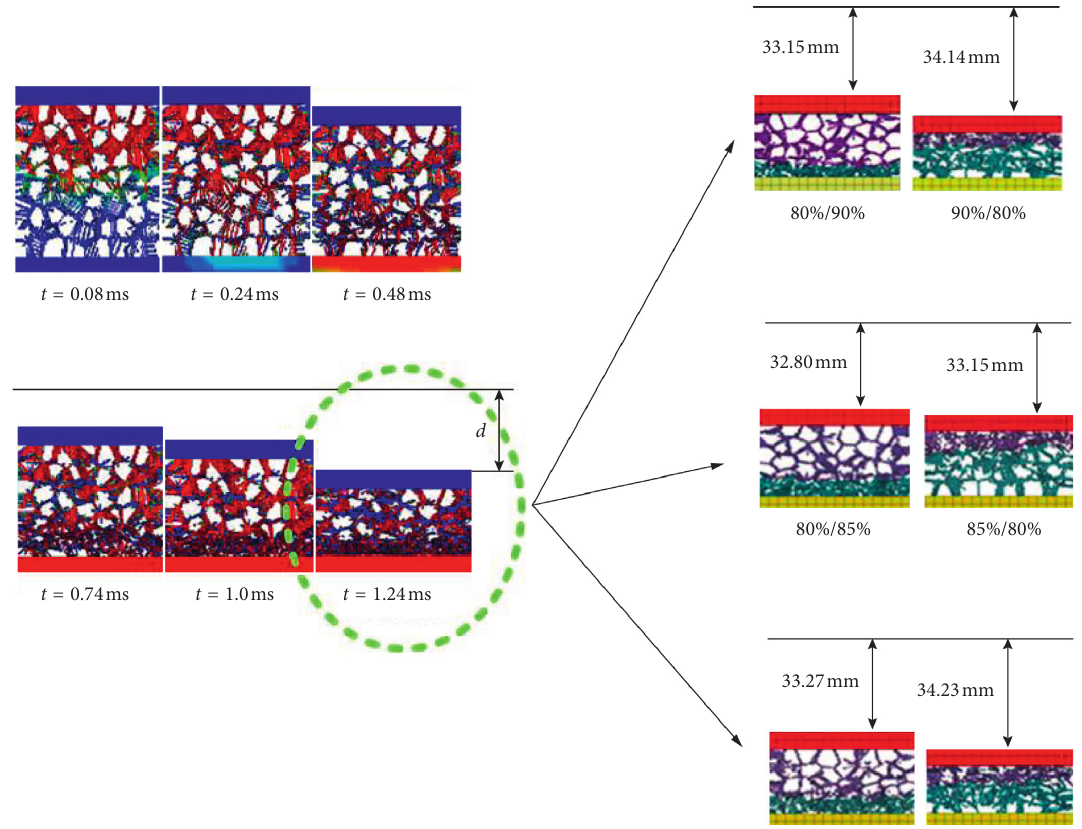
Figure 10: Deformation analysis of six groups of